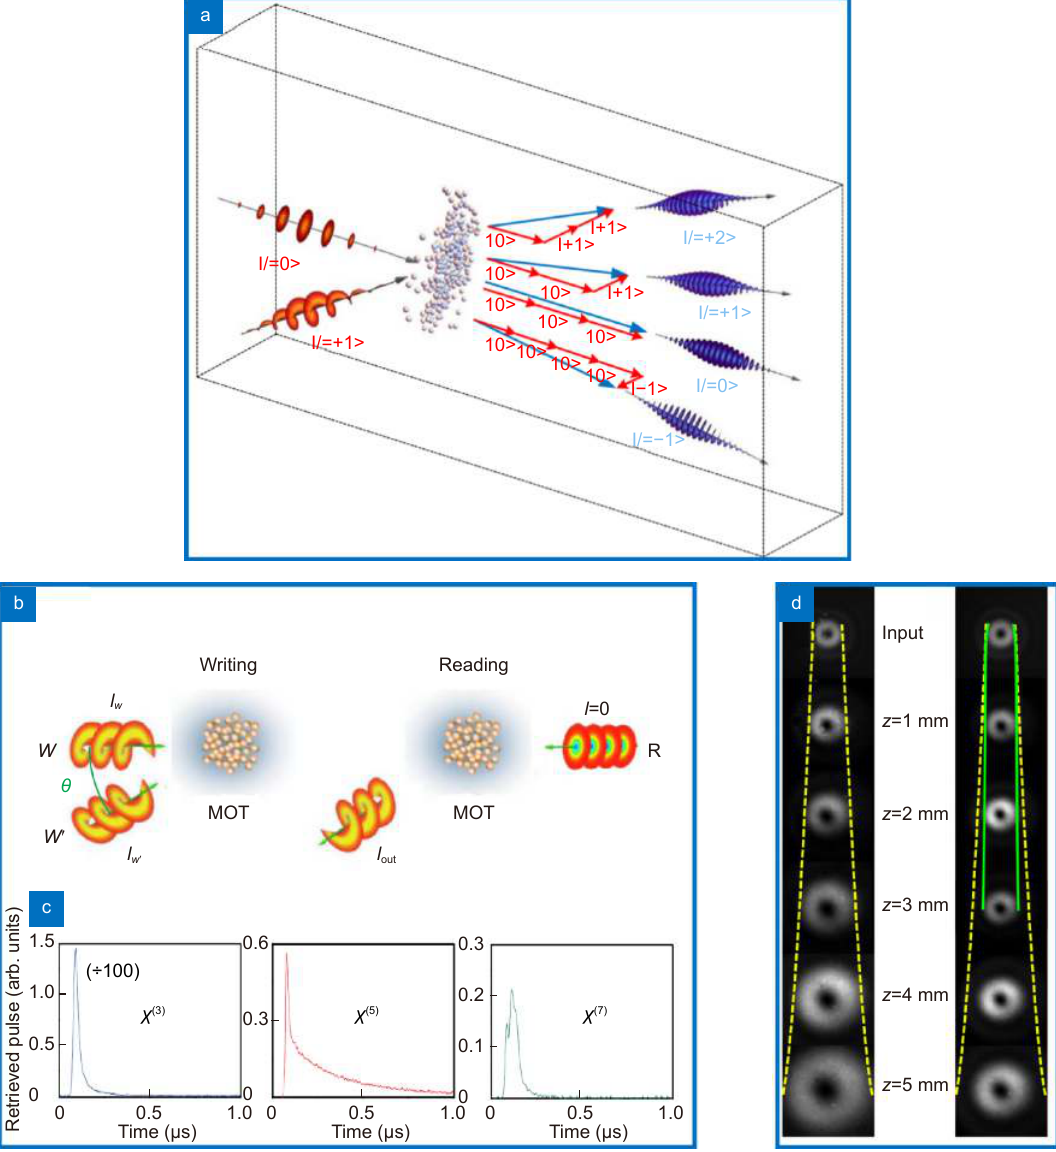
Fig. 5 | Higher order process. In the generation of high harmonic orders, it is possible to generate beams of many different OAM from just two different inputs, as depicted in ( a ). The process of writting and reading optical memory is depicted in ( b ) and the diference in time scales depend- ing on the order of the nonlinear process in ( c ). In ( d ) it is demonstrated robust self-trapping of a bright vortex beam by exploiting higher order nonlinearities of odd orders. Figure repoduced from: (a) ref. 209 , Springer Nature; (b) ref. 191 , © Optica Publishing Group; (c) ref. 192 , © Optica Pub- lishing Group; (d) ref. 204 , © American Physical